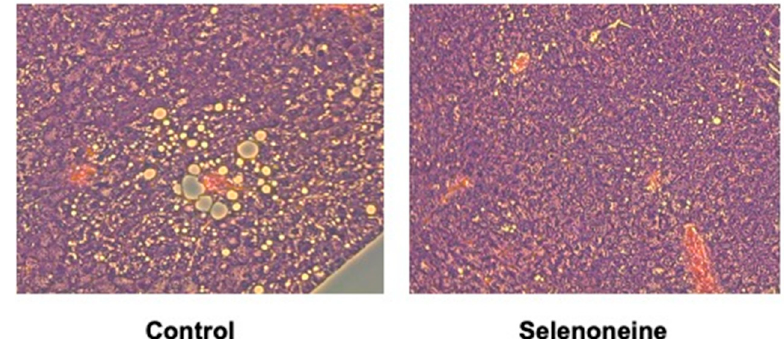
Figure 6. Influence of selenoneine feeding on hepatic histology in Fxr -null mice. Mice were supplemented with 0.3-mg Se/kg selenoneine for 4 months. Representative H&E-stained livers of Fxr -null mice were shown. Original magnification: 100 X.